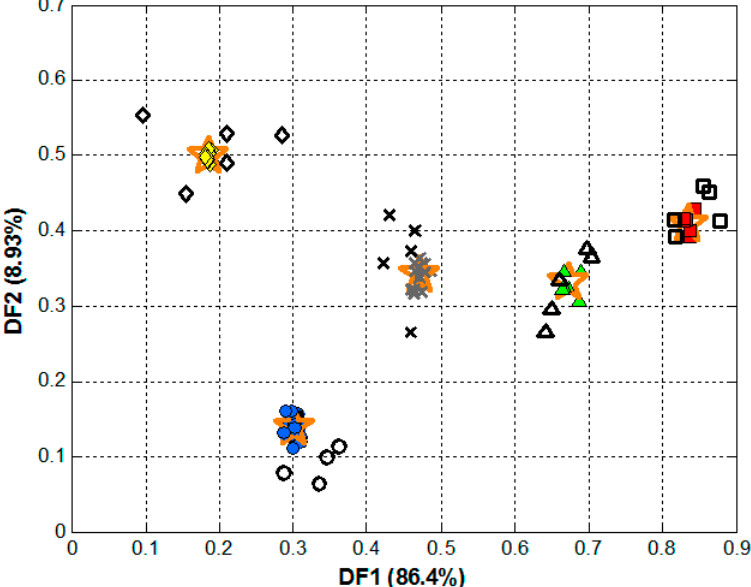
Figure 4. Score plot obtained after LDA analysis of the paprika samples chromatograms: (green ▲ ) Murcia sweet, (red ■ ) Murcia spicy, (blue ● ) La Vera sweet, (yellow ♦ ) La Vera spicy, and (grey x ) La Vera bittersweet. Additionally, the centroid for each of the classes is also plotted ( ★ ). Colored, filled symbols correspond to the samples of the training subset, black empty ones to the testing subset.